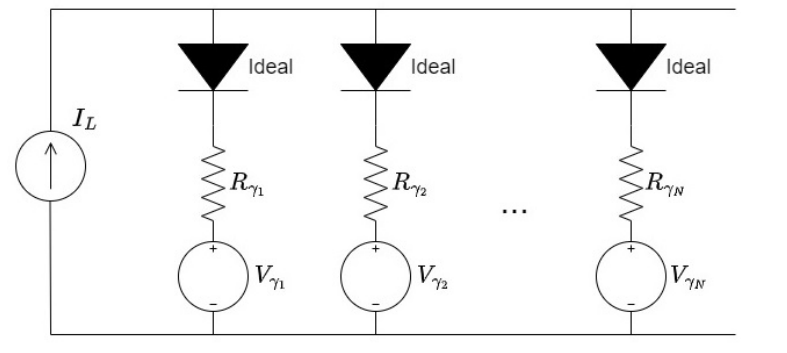
Figure 4. I-V curve for N branches in parallel ( N = 4, as an example).